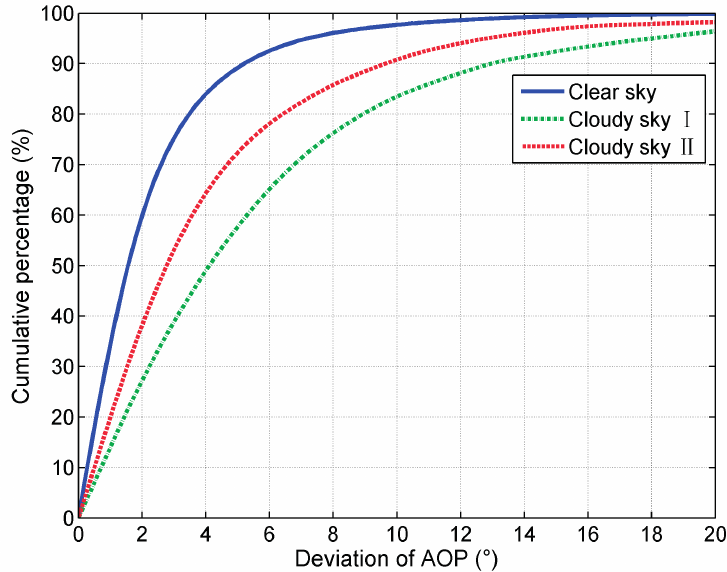
Figure 7. The cumulative percentages of the AOP deviations of the three sky